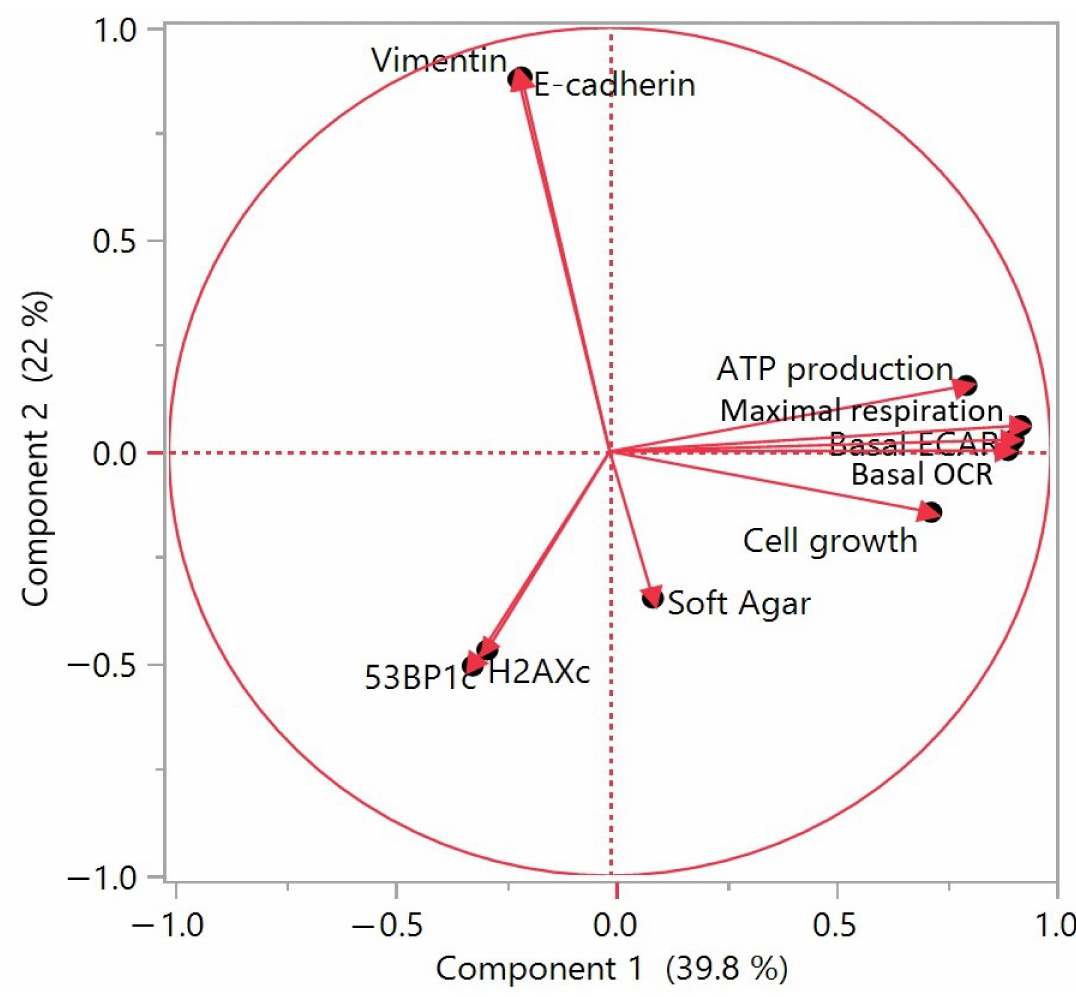
Figure 7. Principal component analysis of long-term exposure results to contaminants in